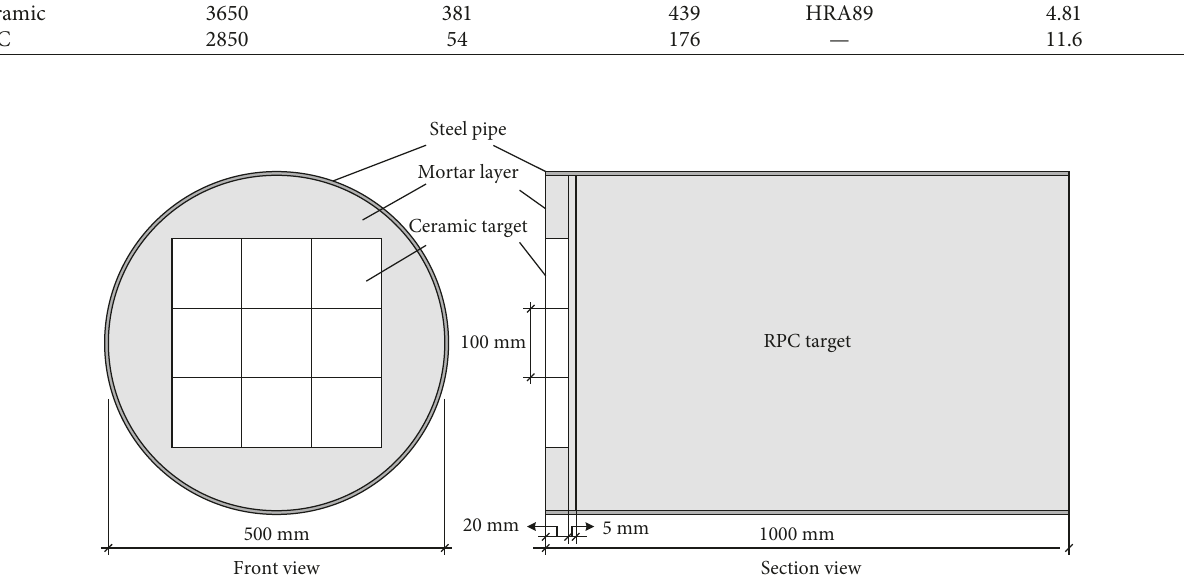
Figure 2: The composition of the C-RPC composite target.